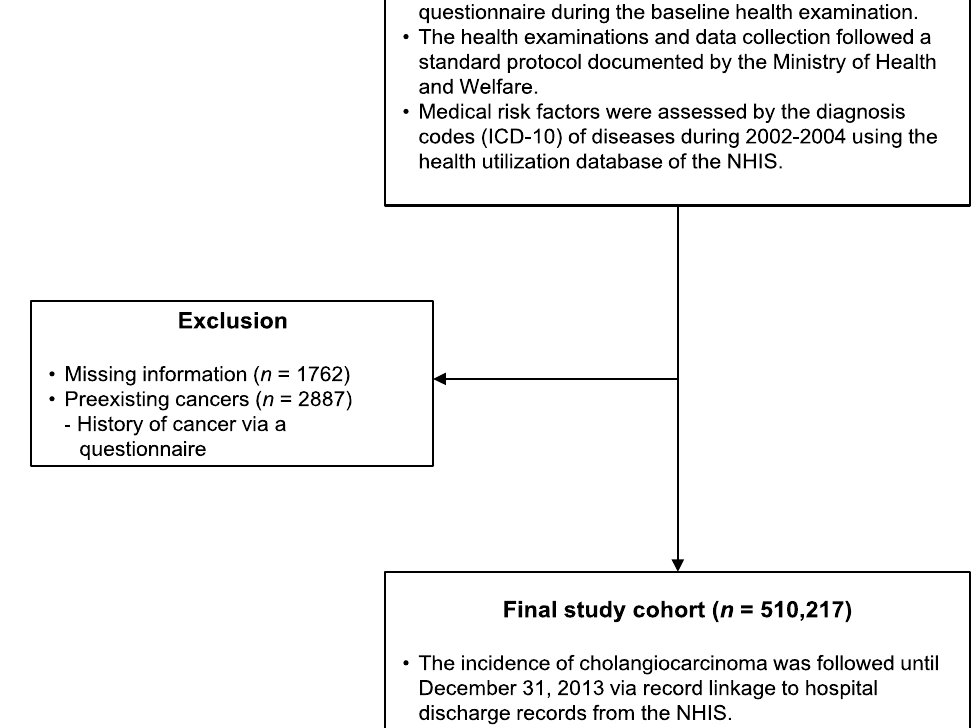
Figure 1. Flow diagram of the study population and design.